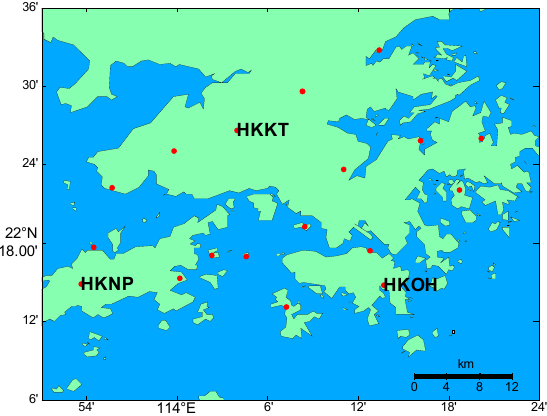
Figure 1. The Global Navigation Satellite System (GNSS) network in Hong Kong. The red points indicate the positions of stations. Three annotated stations, HKNP, HKKT, and HKOH, were applied in this